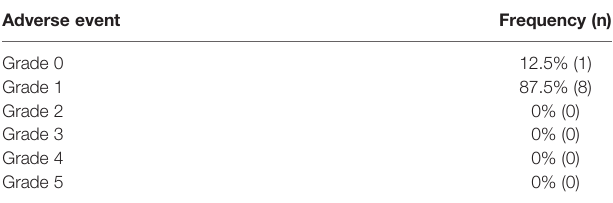
TABLE 2 | Frequency of adverse effects by grade in vaccinated patients.